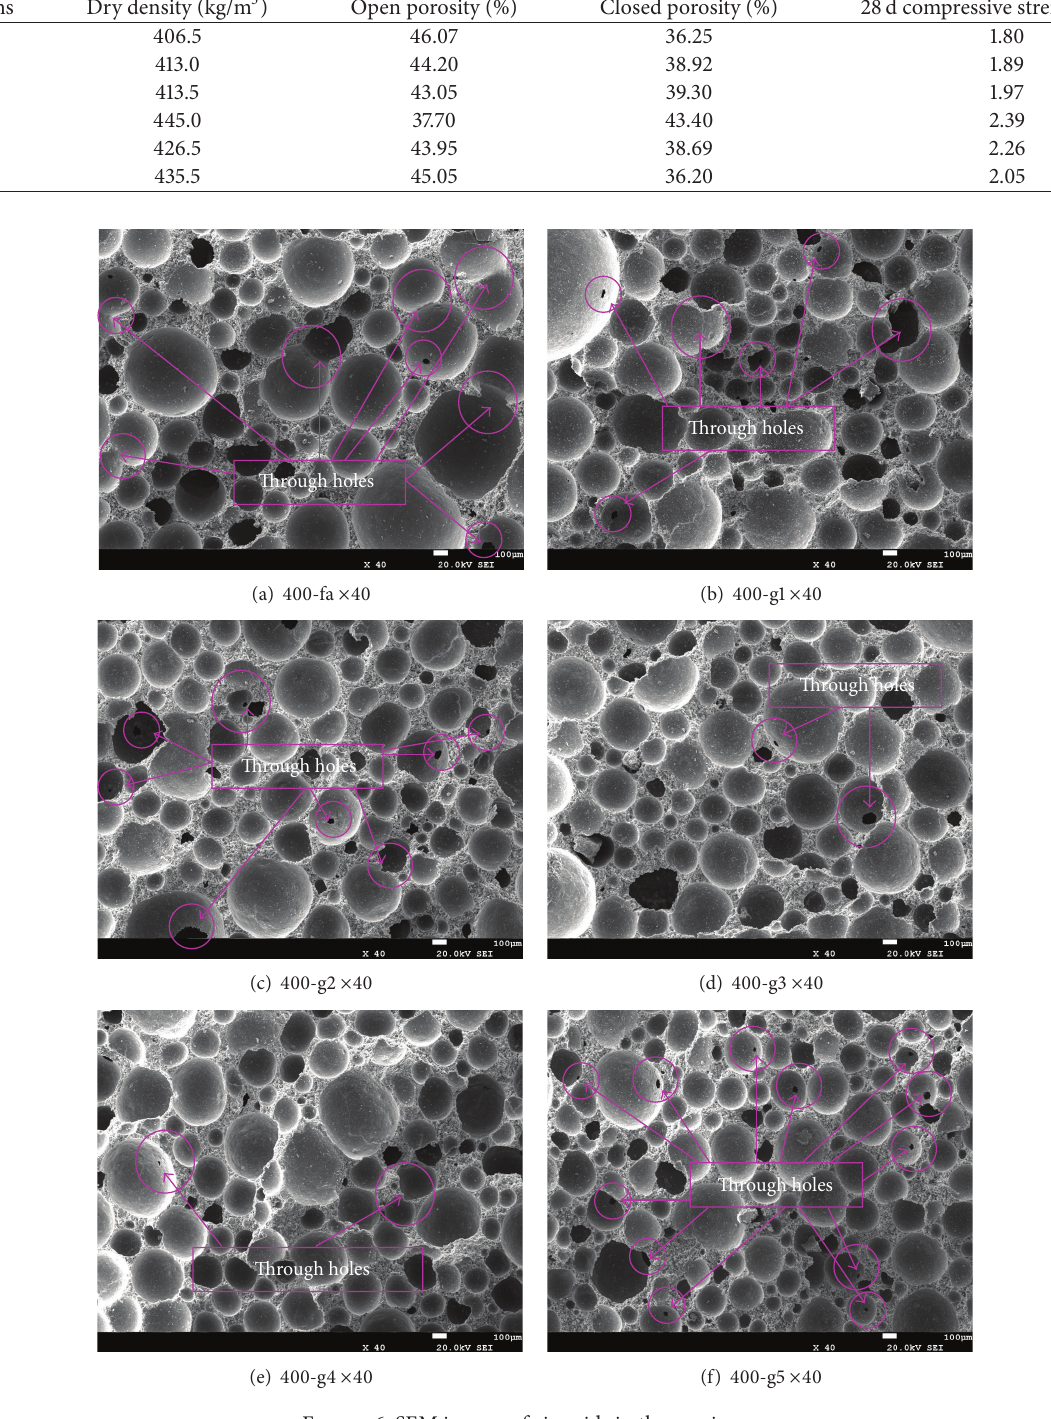
Figure 6: SEM images of air voids in the